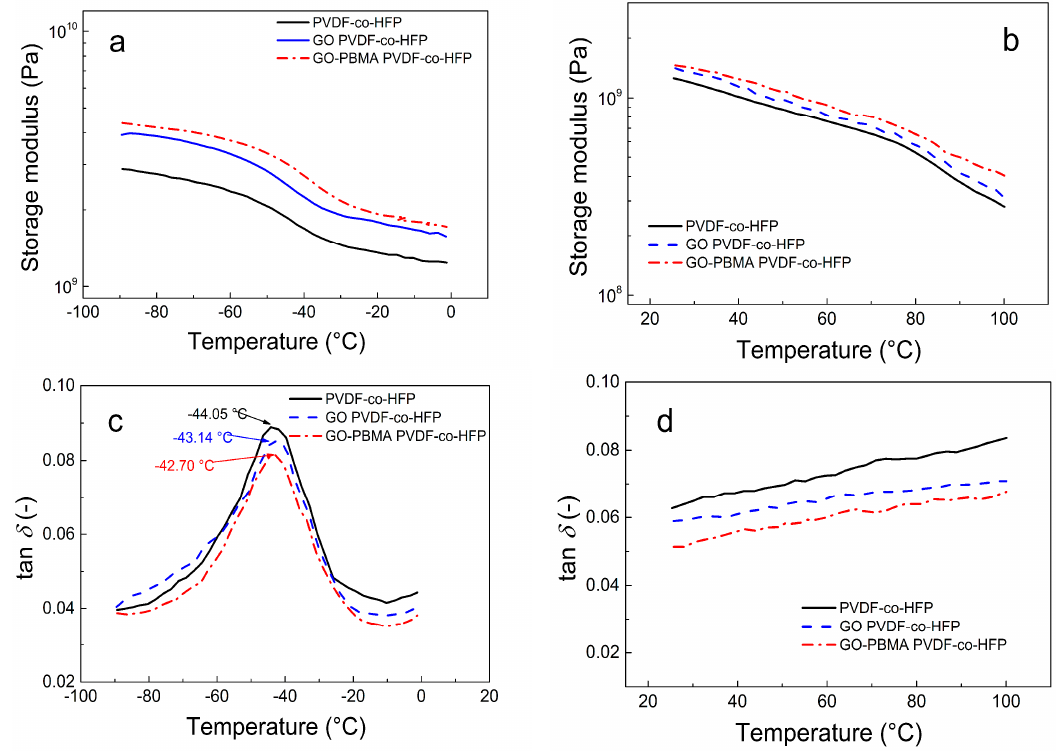
Figure 7. Dynamic mechanical analysis of non-woven fiber mats at temperatures from − 100 to 100 °C upon 1 Hz and 0.01% strain deformation, where ( a , b ) are storage moduli and ( c , d ) are tan δ .